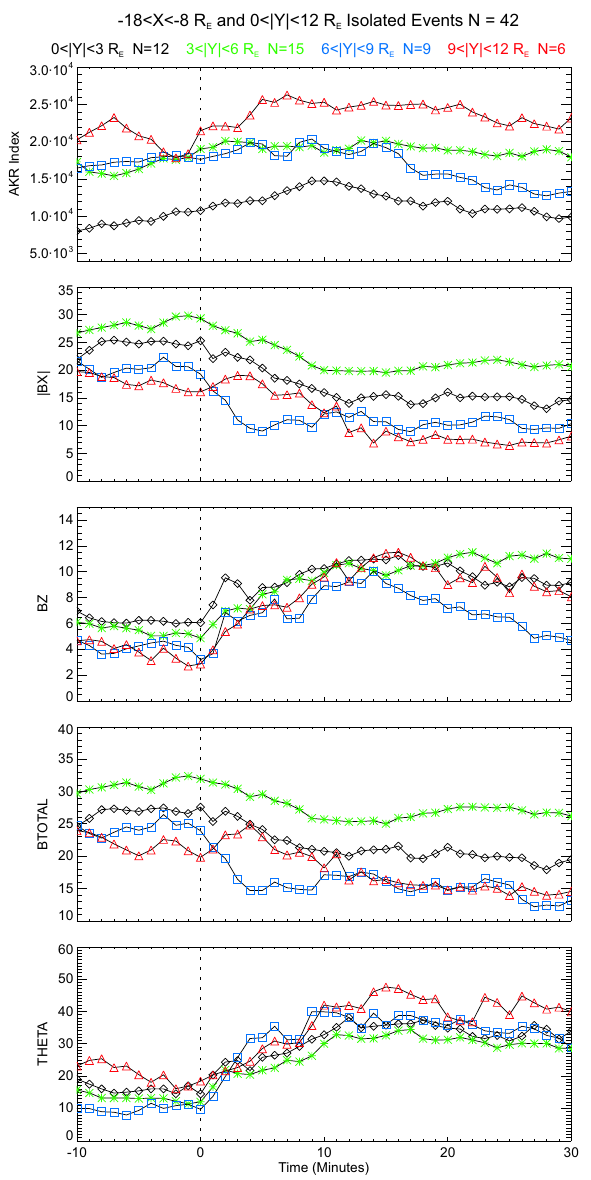
Fig. 10. Results of the superposed epoch study showing the de- pendence of dipolarization properties on the Y GSM position for the isolated events. We used 1min averages of the magnetic field in the regions 0 < | Y | < 3 R E , 3 < | Y | < 6 R E , 6 < | Y | < 9 R E , and 9 < | Y | < 12 R E . The absolute value of B x is plotted in Fig. 10 to prevent B x from averaging to zero. The AKR index was obtained by integrating the Wind WAVES data as described in Sect.